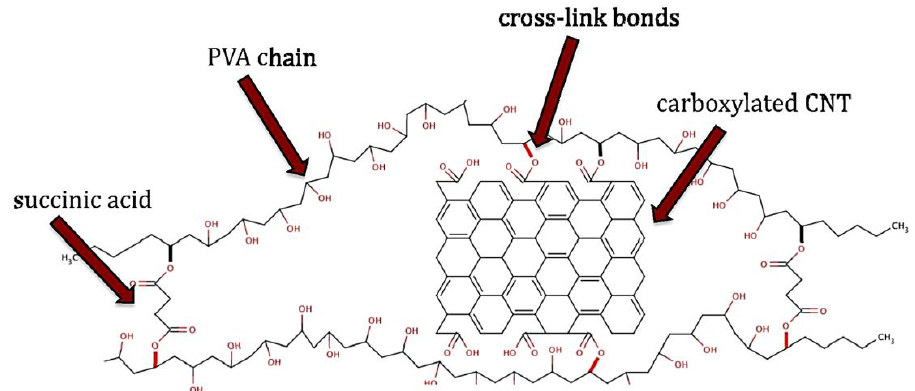
Figure 13. Thin layer of PVA covalently cross-linked to MWCNTs–COOH and succinic acid onto a cellulose nitrate membrane. The succinic acid molecules and MWCNTs–COOH cross-linked the PVA strands, immobilizing MWCNTs and altering the spacing between PVA strands. Reprinted from [137], with permission from Elsevier.